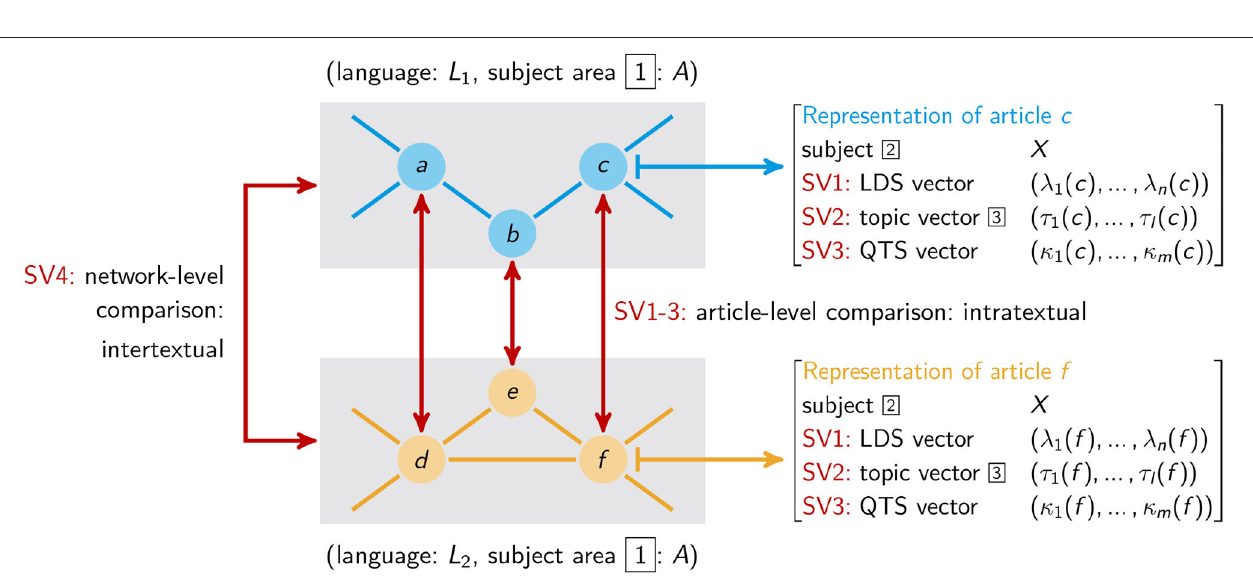
FIGURE 5 | Extracts of two item networks of articles each describing a separate painting: extracted from German (Left) and Dutch Wikipedia (Right) . Download: June 2017.